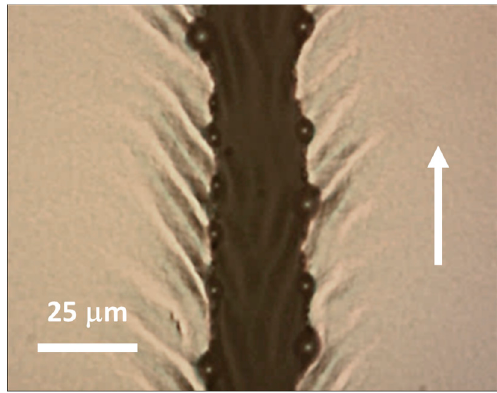
Figure 5. Optical microscopy of a dewetted Ag film on the Par-C polymer substrate. The laser scan of the dewetted Par-C surface appears along the dark center with ridges of dewetted metal along the edge. The beam was scanned in the direction of the arrow. Dewetted silver ridges exhibit an instability and degrade into discrete beads.